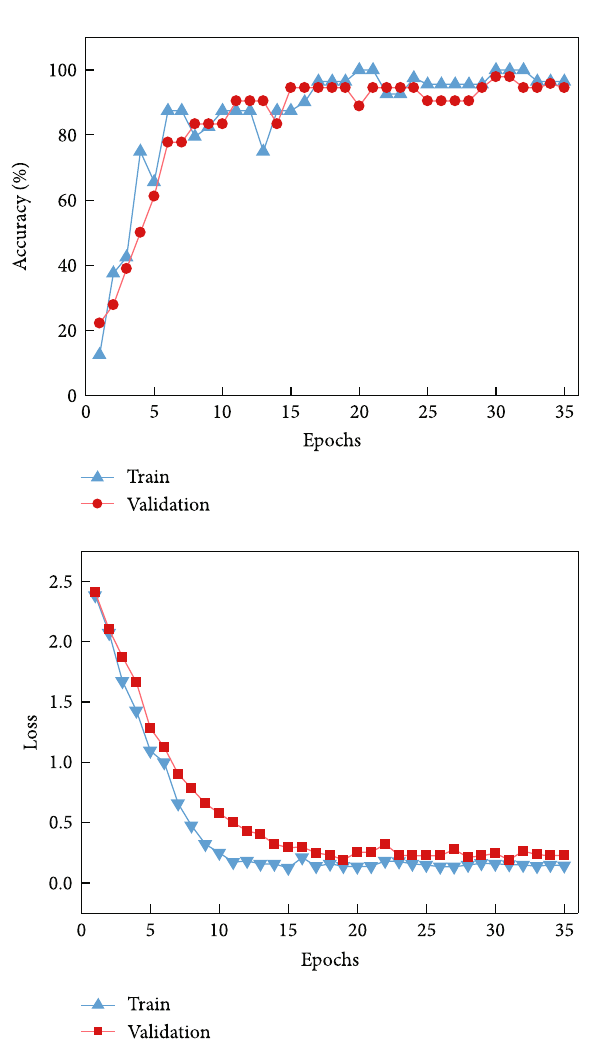
Figure 13: Accuracy and loss during training.